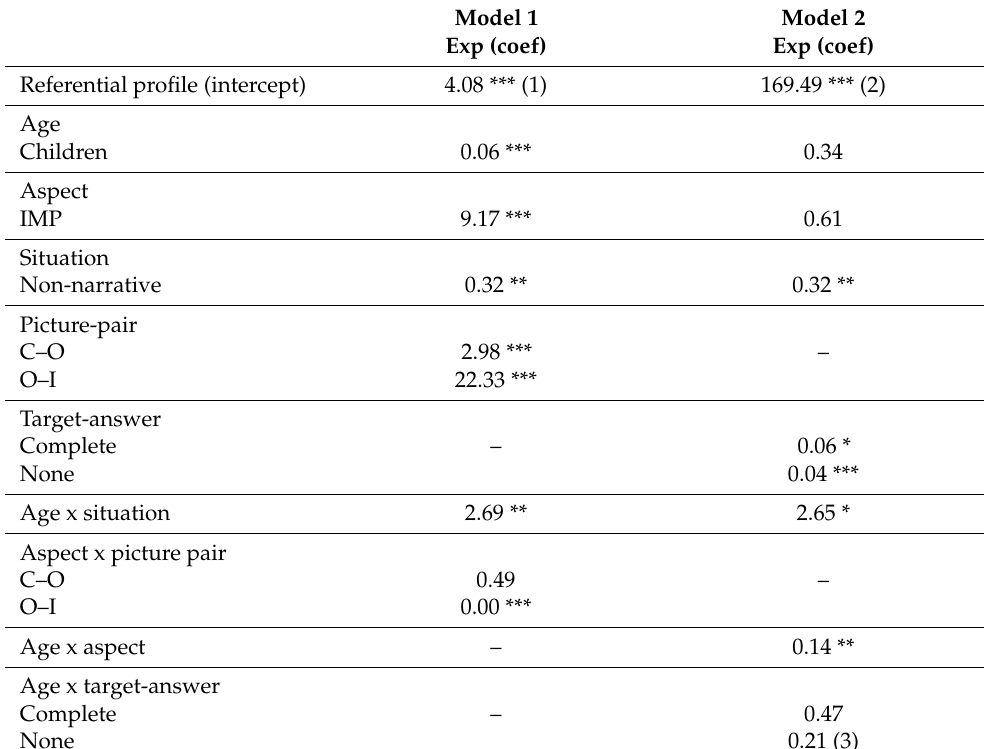
Figure 8. Proportion of target responses per age group and experimental setting for the O–I condition. Table 4. Results from the logistic models with mixed effects. “–” indicates that the corresponding variable is not part of the